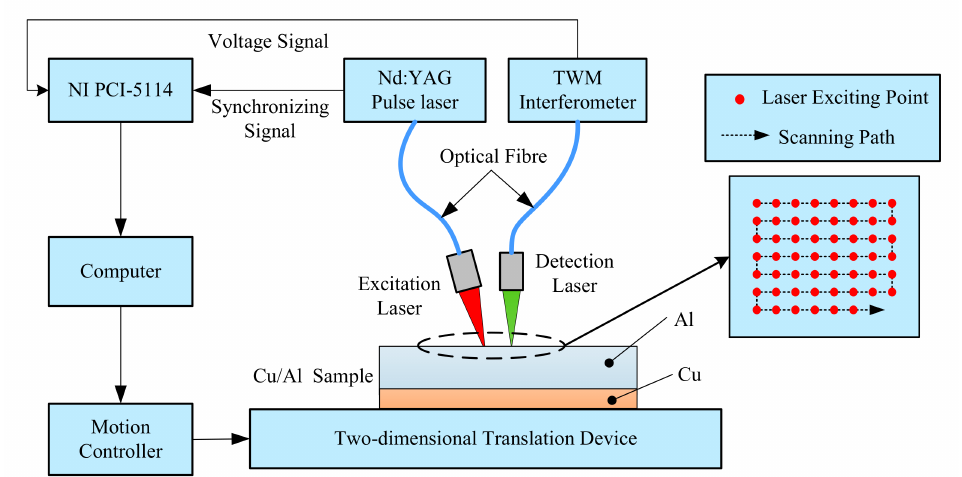
Figure 2. Schematic diagram of experimental device.